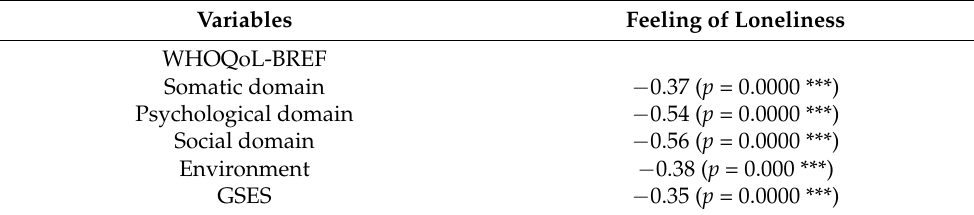
Table 3. A sense of loneliness in correlation with quality of life and generalized self-efficacy.